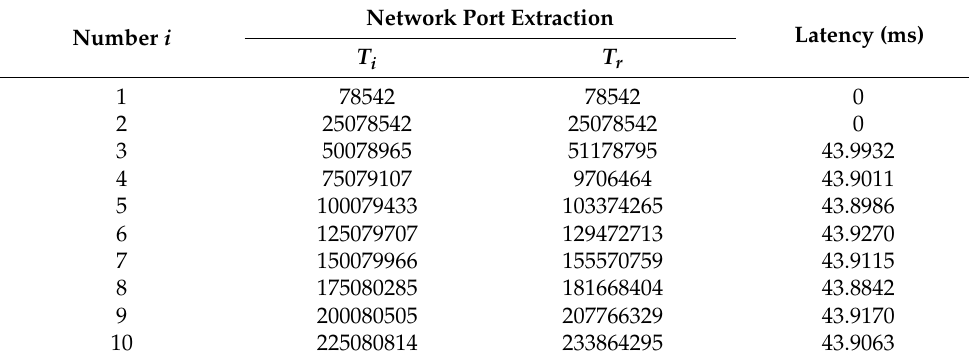
Table 1. Latency results in the First 10 s of video